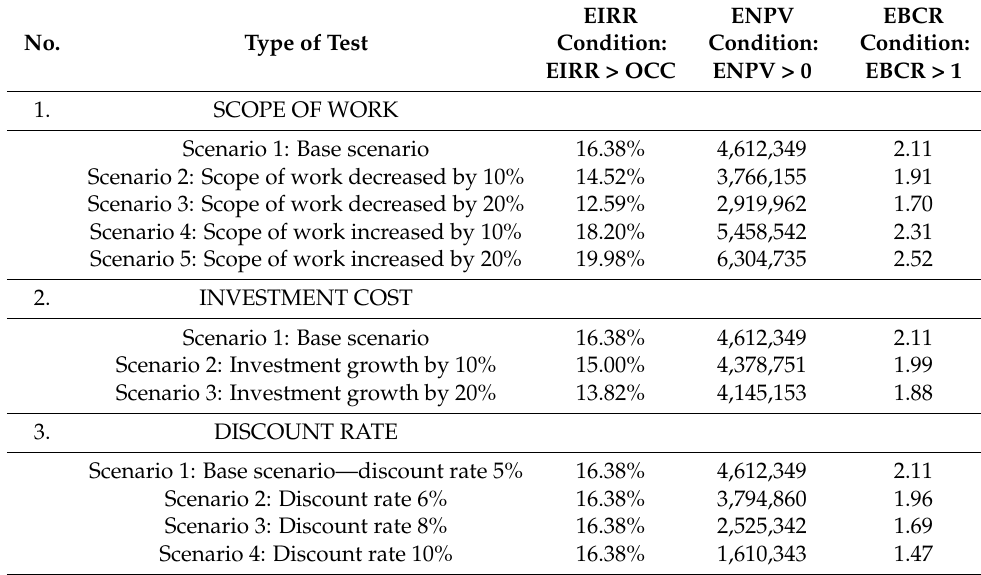
Table 15. Sensitivity analysis results of the WWTP